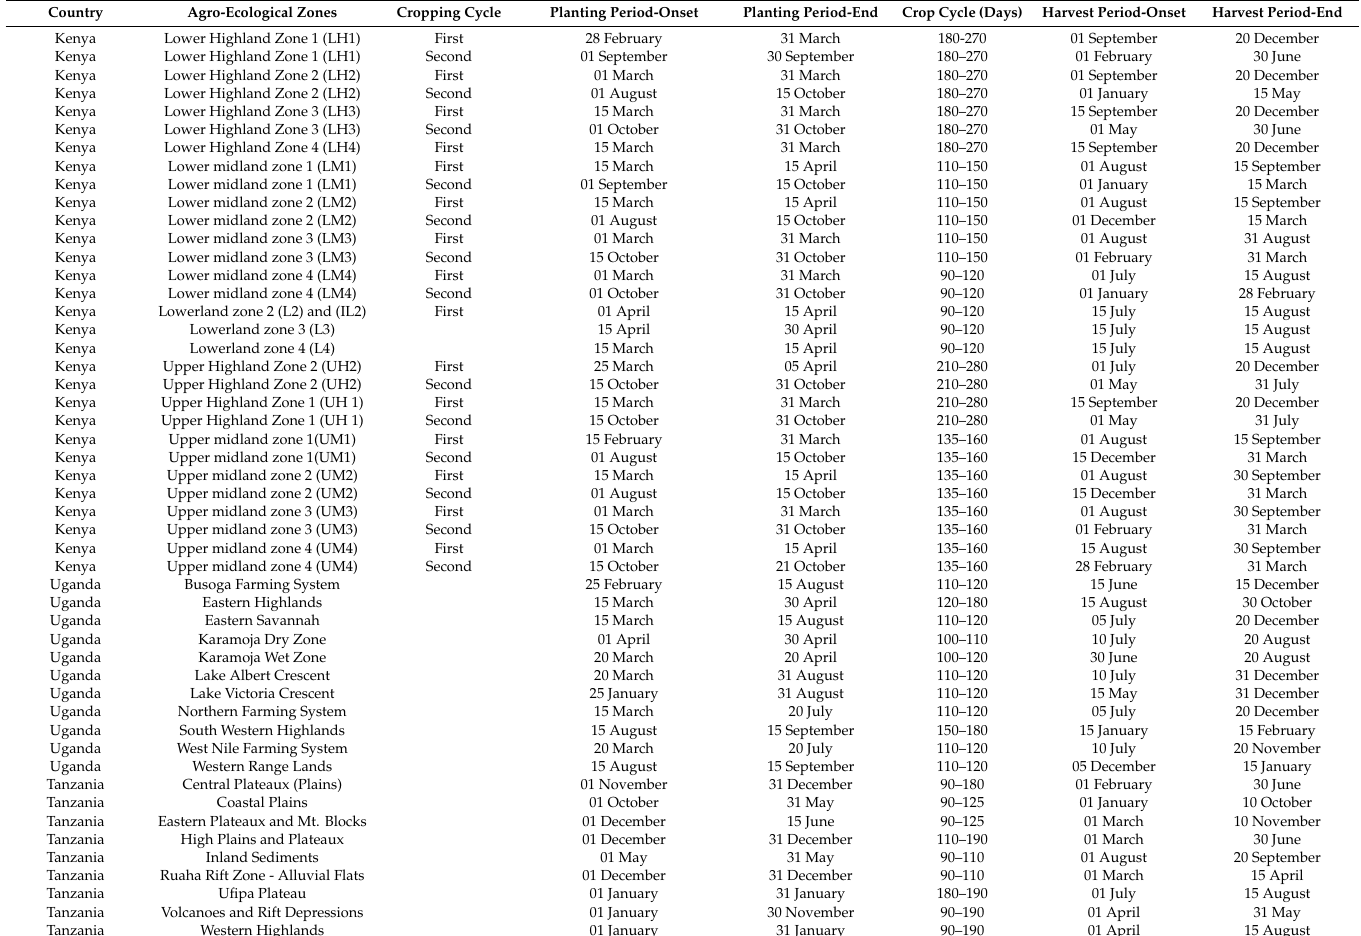
Table A2. Agricultural calendar showing planting and harvesting periods, as well as crop cycles within each agro-ecological zone in Kenya, Uganda and Tanzania. Source: